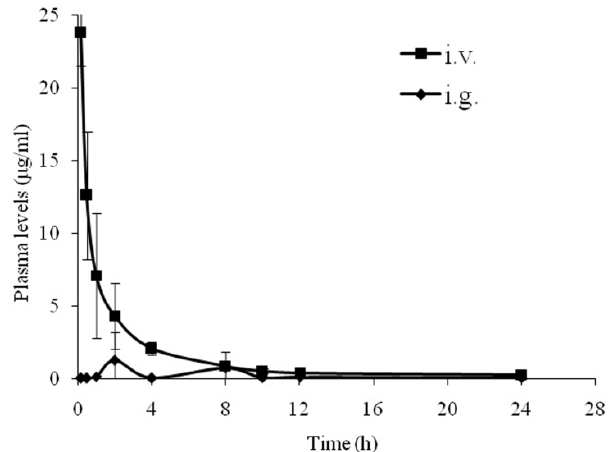
Figure 3. Plasma concentration (ng/mL) versus time (h) profiles of NCE after i.v. and i.g. administration of 30 mg/kg in beagle dogs ( n =